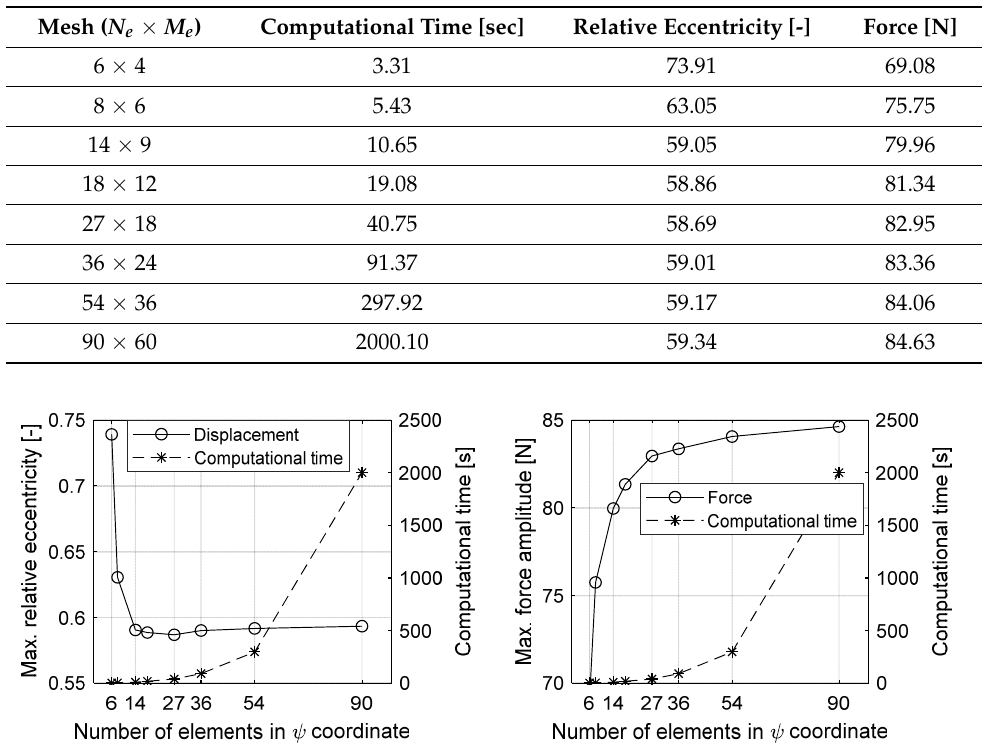
Figure 15. The computational time plotted together with the relative eccentricity and force amplitudes as a function of number of elements in circumferential coordinates.